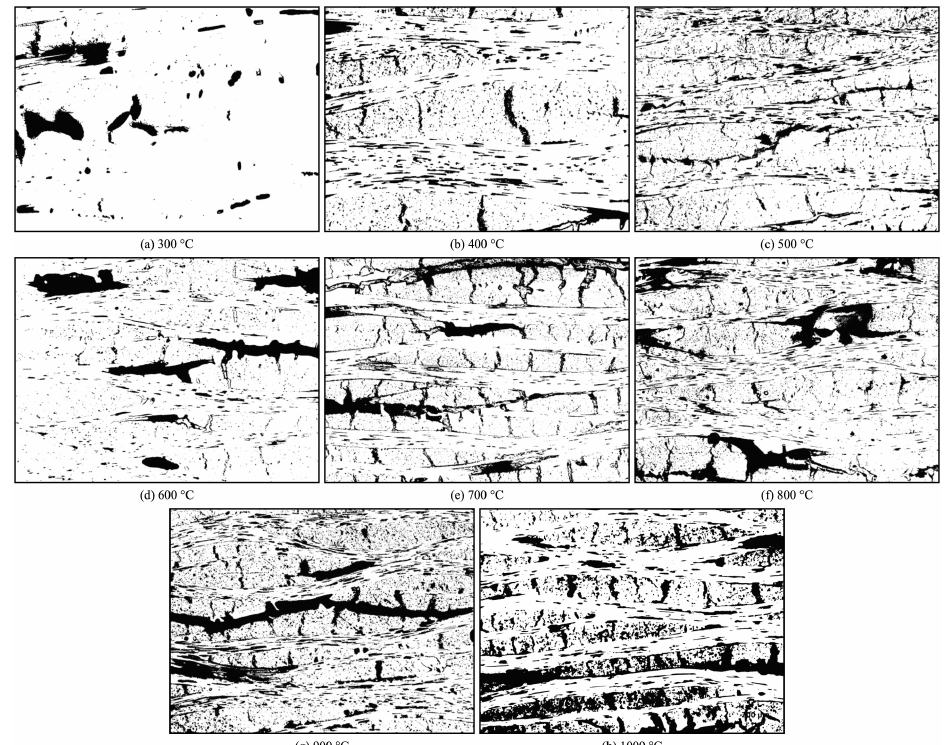
Figure 6. Image segmentation from Figure